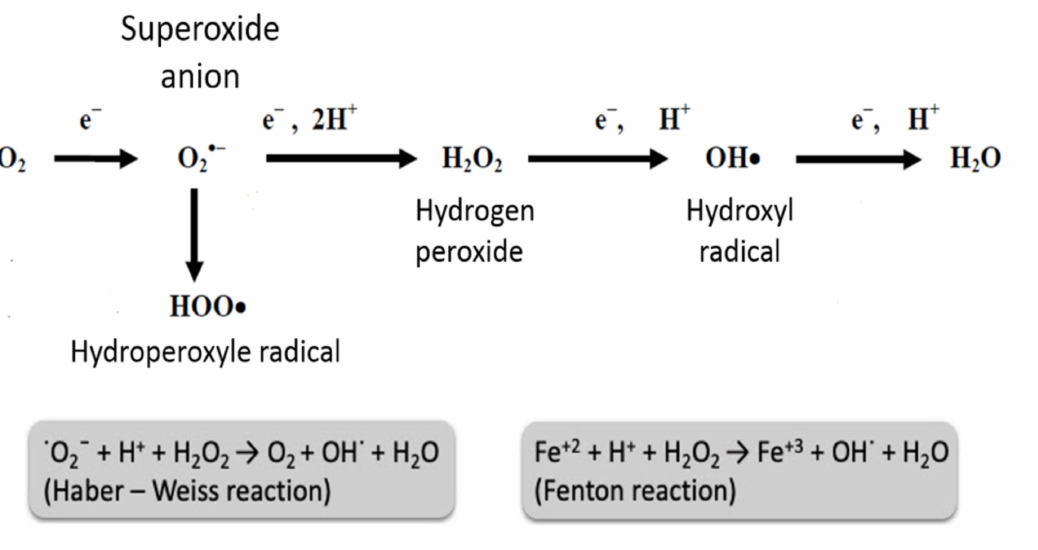
Figure 1. Reactive oxygen species. O 2 •− -superoxide anion, OH • -hydroxyl radical, H 2 O 2 -hydrogen peroxide, HOO • -hydroperoxyle radical, H 2